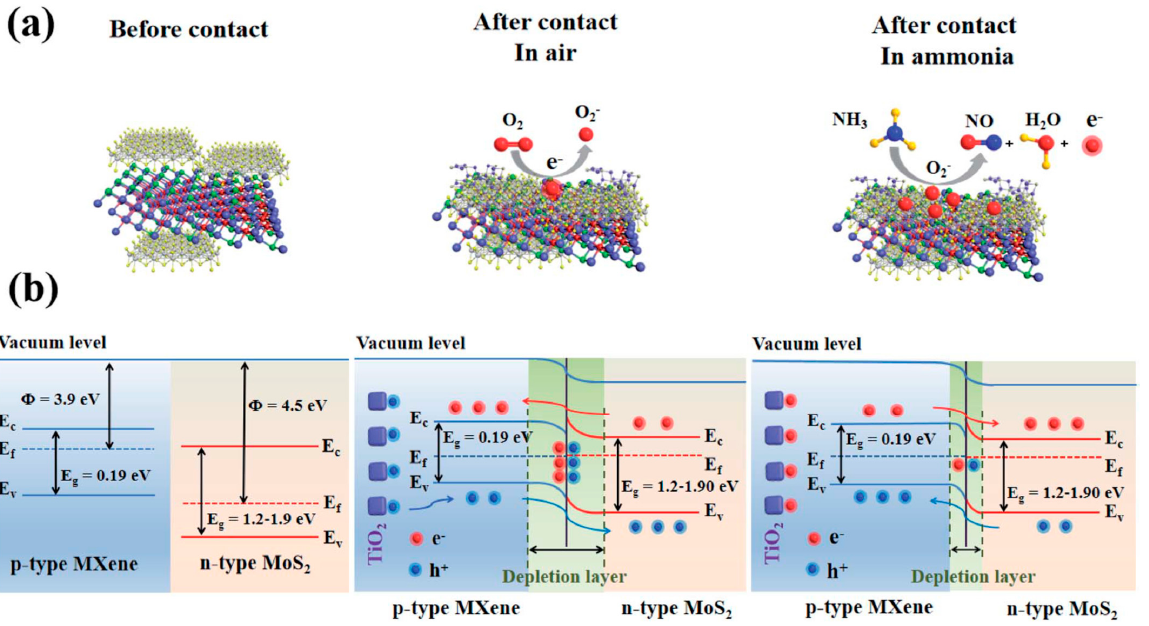
Figure 35. ( a ) Schematic illustration of the proposed gas-sensing mechanism; ( b ) energy band dia- grams of the sensor comprosed of Ti 3 C 2 T x MXene@TiO 2 /MoS 2 . Reprinted with permission from [152]. Copyright 2022: The Royal Society of Chemistry. Chen et al. [153] synthesized a Ti 3 C 2 T x /WSe 2 (2 and 4 wt.%) nanohybrid combining